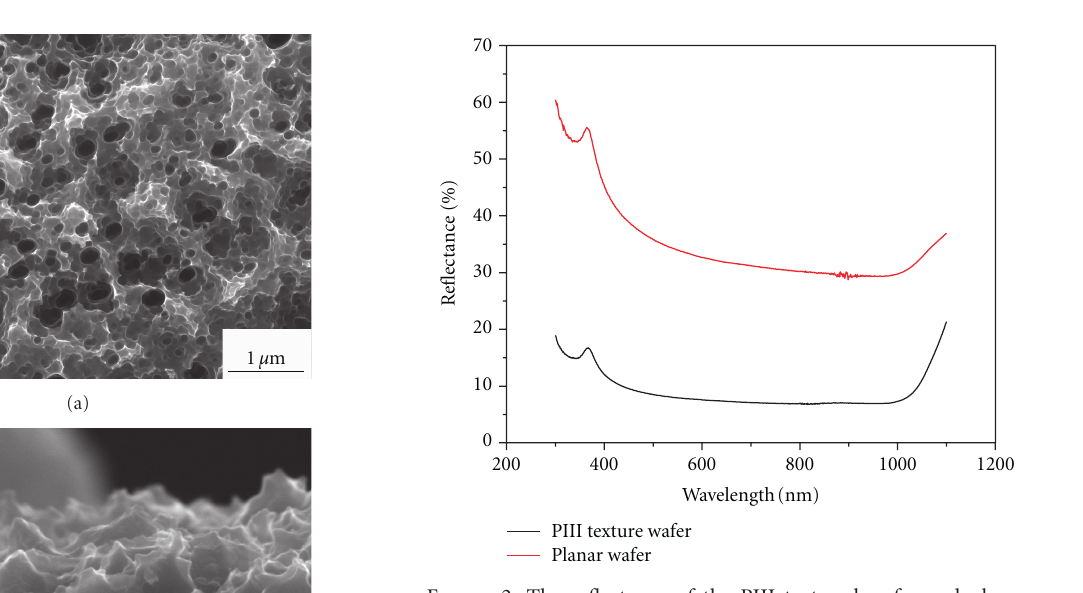
Figure 2: The reflectance of the PIII textured wafer and planar wafer varying with wavelength from 300 nm to 1100 nm.